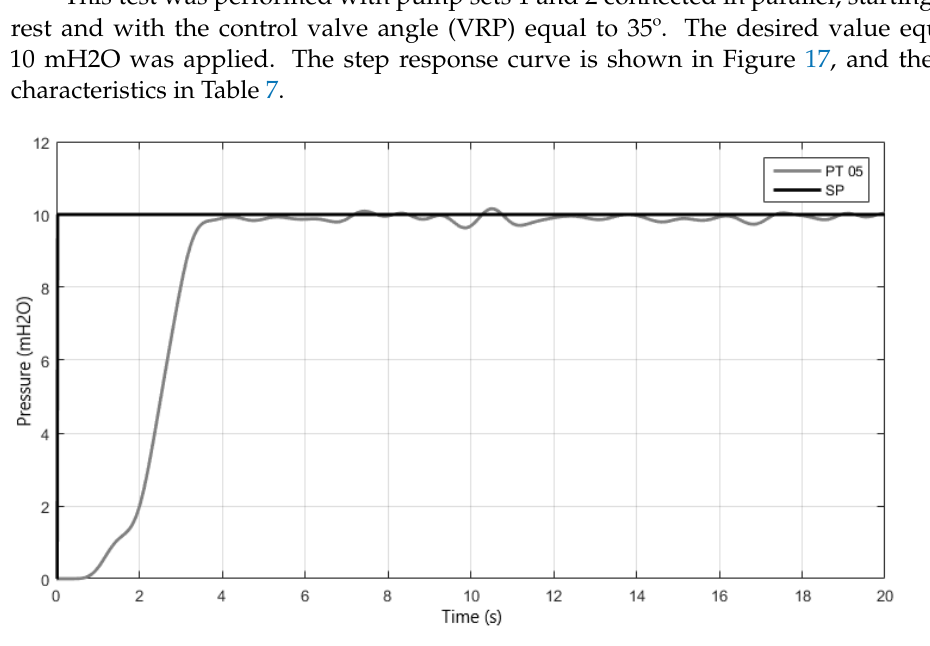
Figure 17. Response of fuzzy control with pumps operating in parallel. Table 7. Time characteristics of the response of fuzzy control with pumps operating in